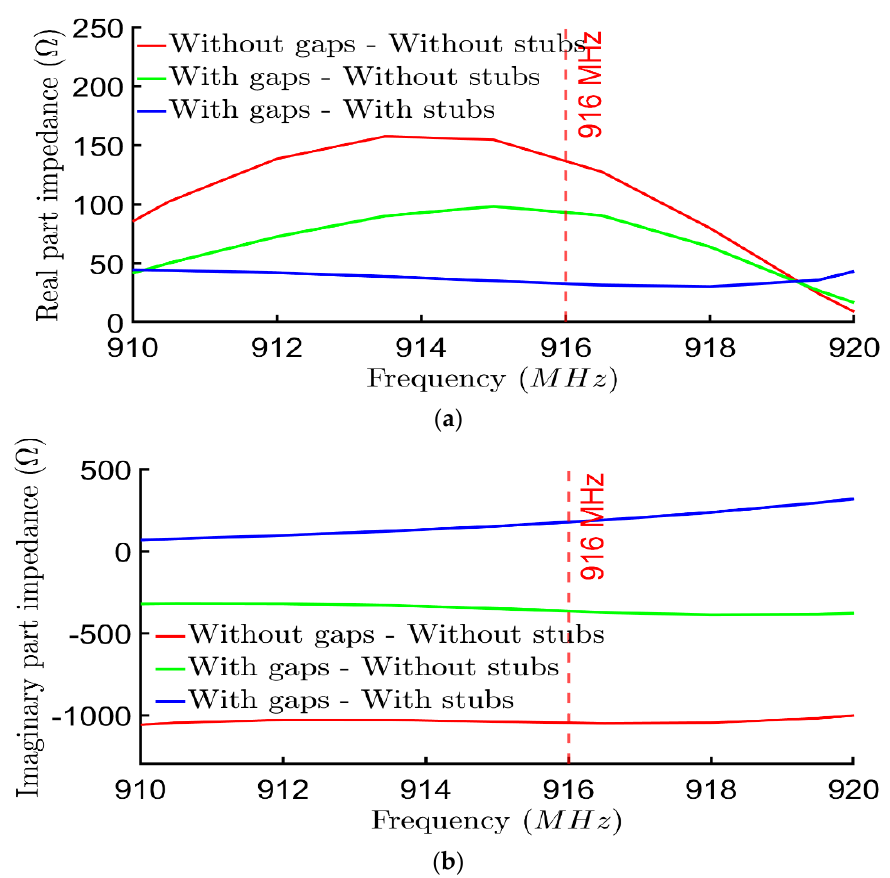
Figure 6. Proposed structure impedance with different configurations: without stubs without gaps; without stubs with gaps; with stubs with gaps: ( a ) The real part of the impedance; ( b ) The imaginary part of the impedance.